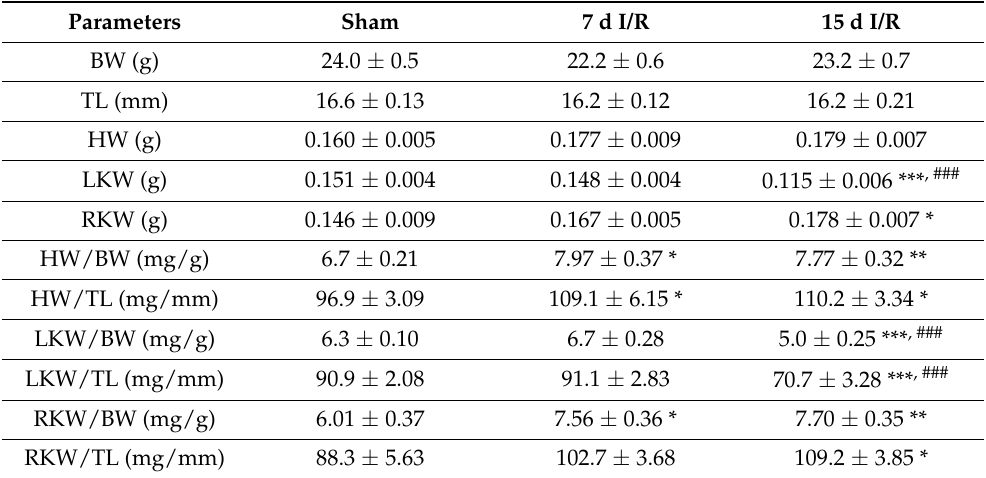
Table 1. Macroscopic parameters in the ARF model 7 and 15 days following renal ischemia and reperfusion. Parameters